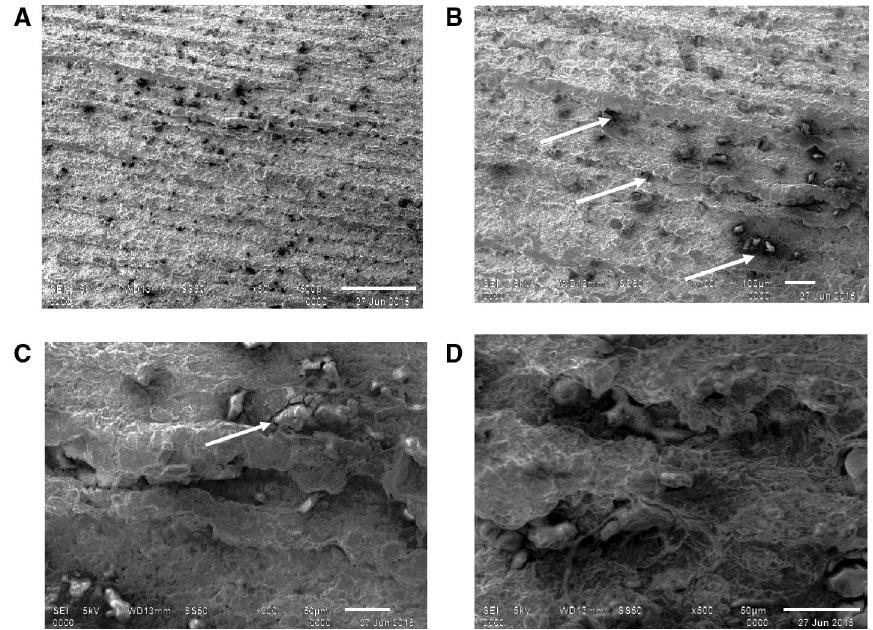
Figure 14: (A) Scanning electron micrograph of the mid-weld zone at a magnification of 50×. (B) SEM of the mid-weld zone at a magnification of 100×. (C) SEM of the mid-weld zone at a magnification of 300×. (D) SEM of the mid-weld zone at a magnification of